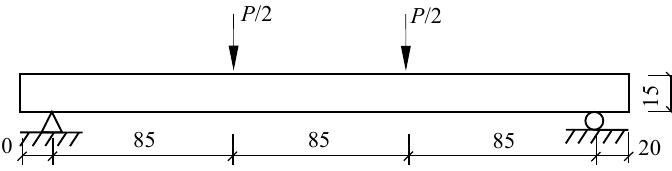
Figure 6. Schematic setup of the four-point bending test.